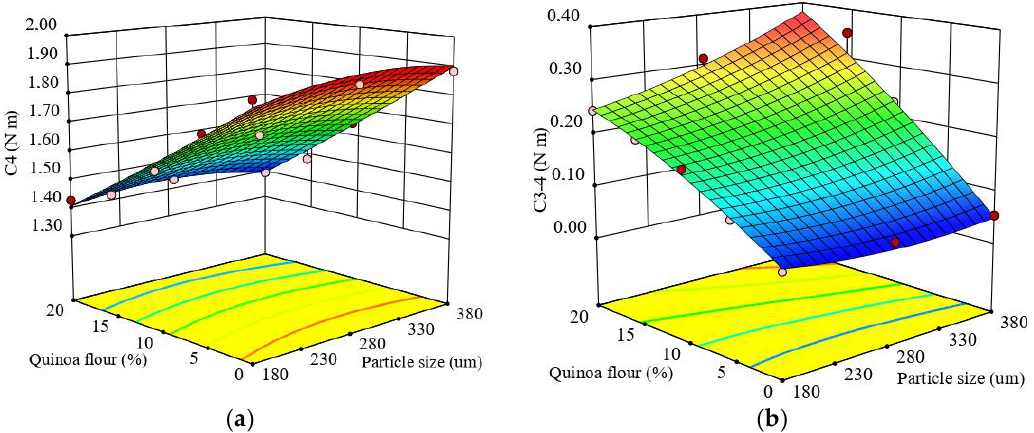
Figure 4. Response surface graph for combined effects of quinoa flour particle size and level added in refined wheat flour on Mixolab parameters during cooking stage: ( a ) C4 torque (C4) and ( b ) difference between torques C3 and C4 (C3–4).